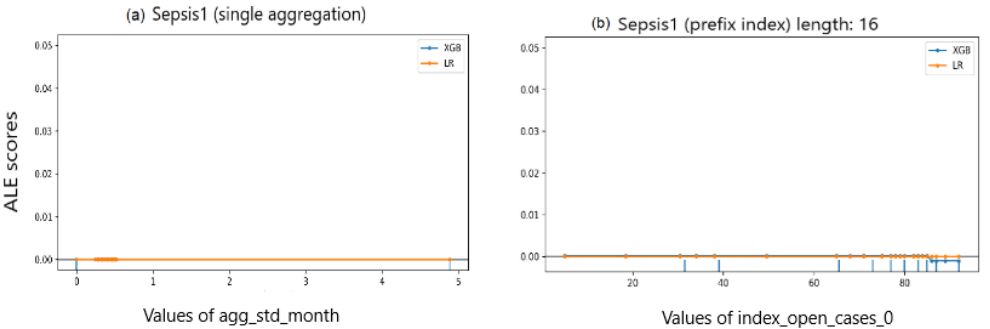
Figure 8. ALE scores of Sepsis1 event